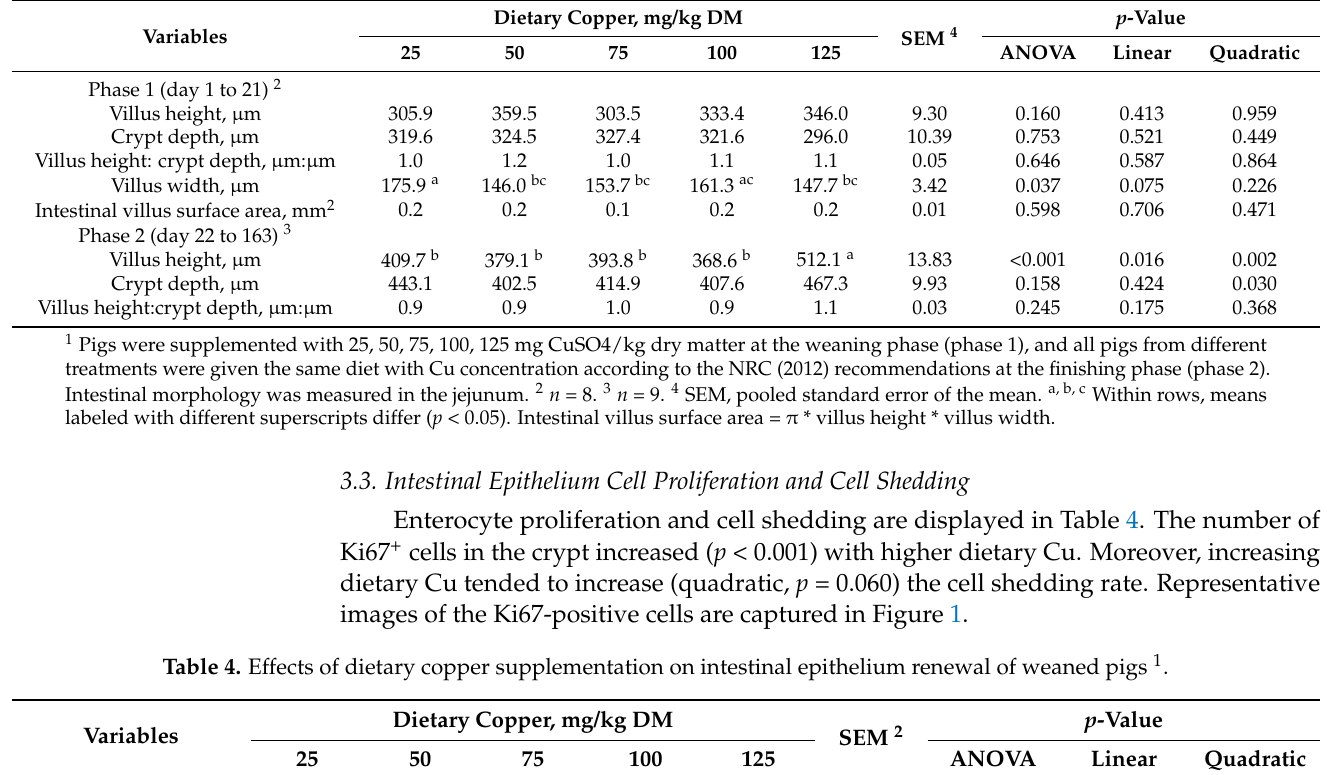
Table 3. Effects of dietary copper supplementation during the weaning period on intestinal morphology of weaned and finished pigs 1 . Variables